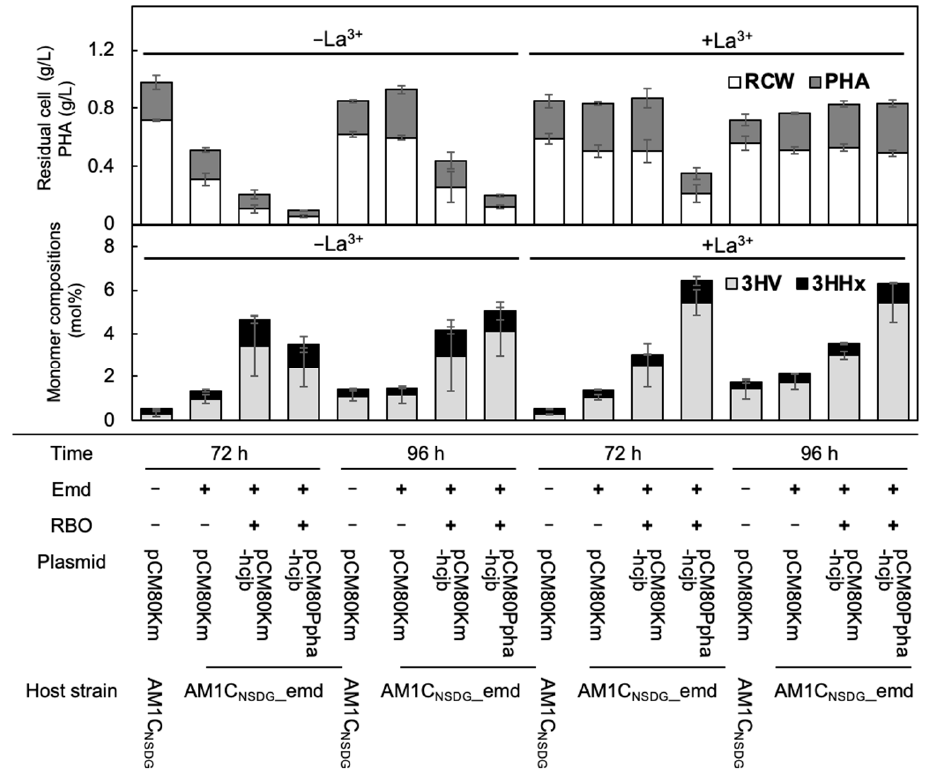
Figure 2. P(3HB- co -3HV- co -3HHx) biosynthesis from methanol by engineered strains of M. extorquens in the absence or presence of La 3+ . The cells were grown in 100 mL hypho medium containing 0.5% ( v / v ) methanol and trace element solution with EDTA for 72 h or 96 h. n = 4 ( n = 2 for Table 3. Effect of lanthanide on P(3HB- co -3HV- co -3HHx) biosynthesis by M. extorquens recombinant strains from methanol.